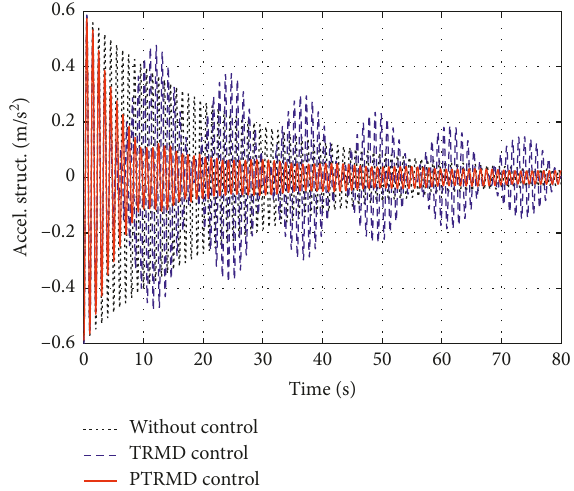
Figure 15: Acceleration response of the structure under sinusoidal excitation.